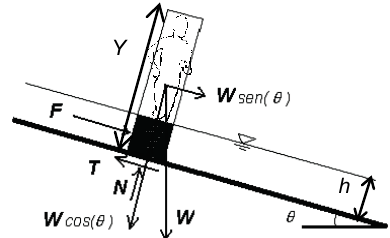
Fig. 3 Scheme of the forces acting on the schematized human